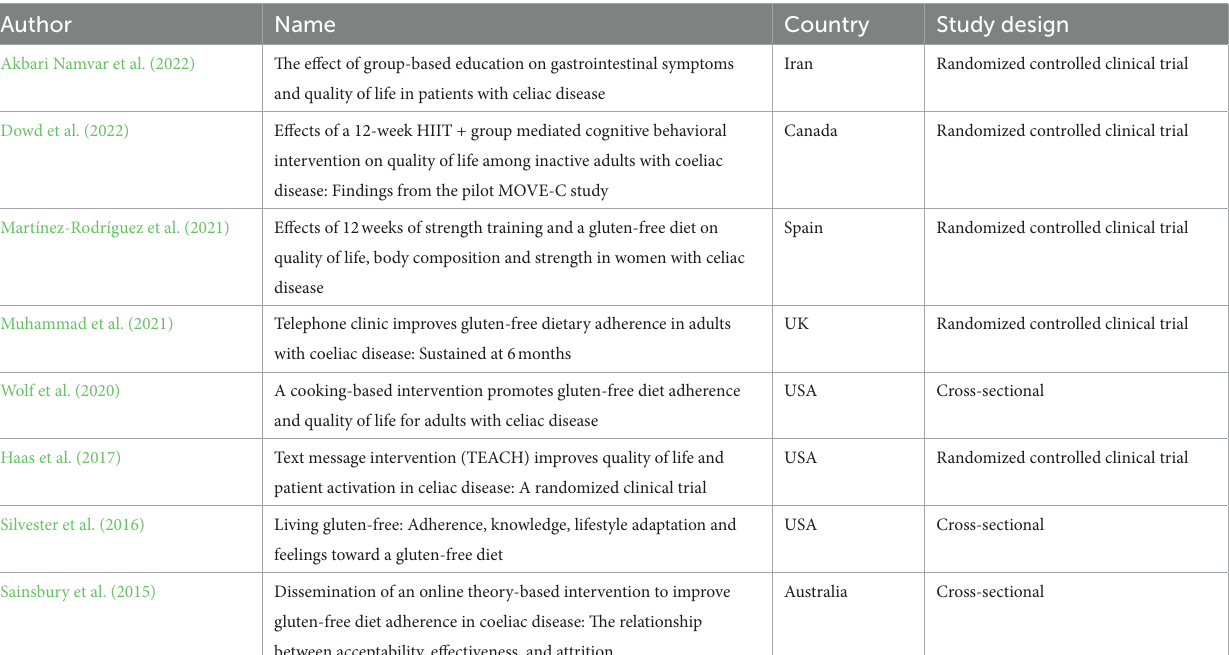
TABLE 2 Summary of the included